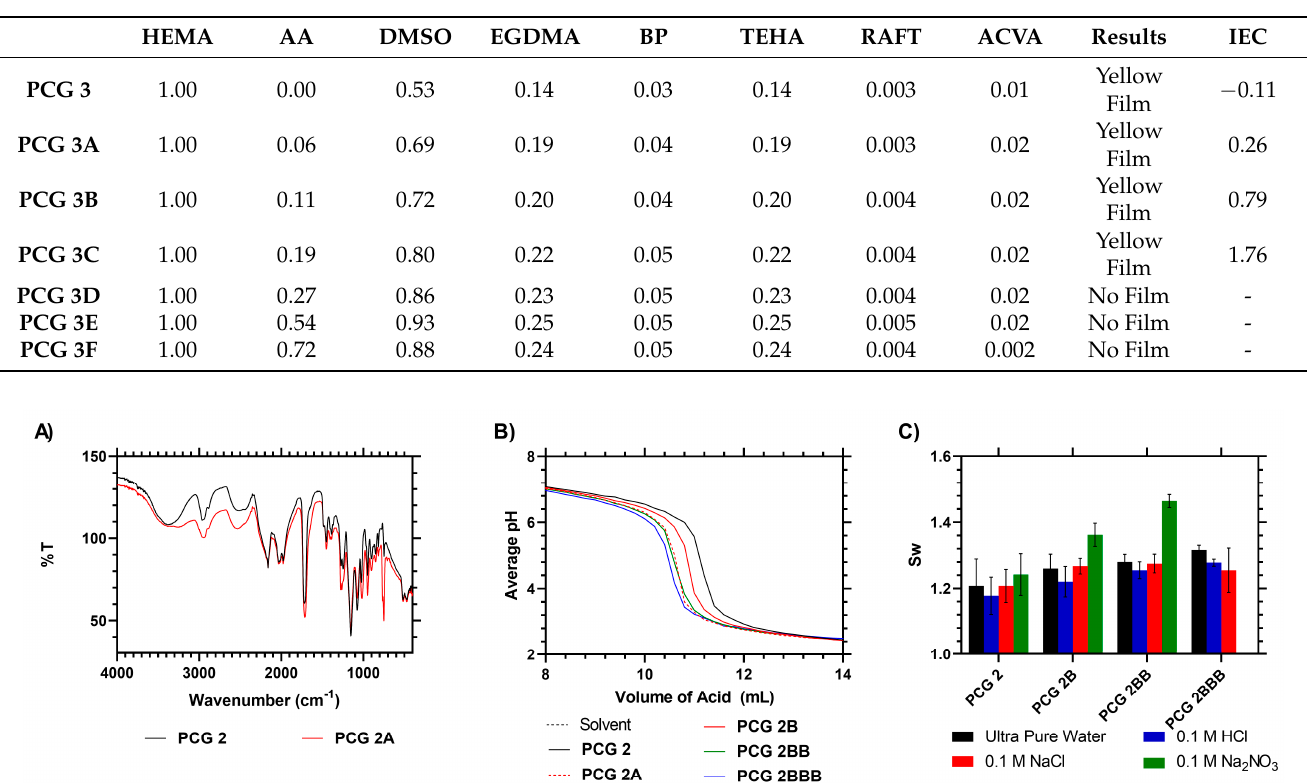
Table 3. Molar ratio of HEMA-co-AA IPN film synthesis.